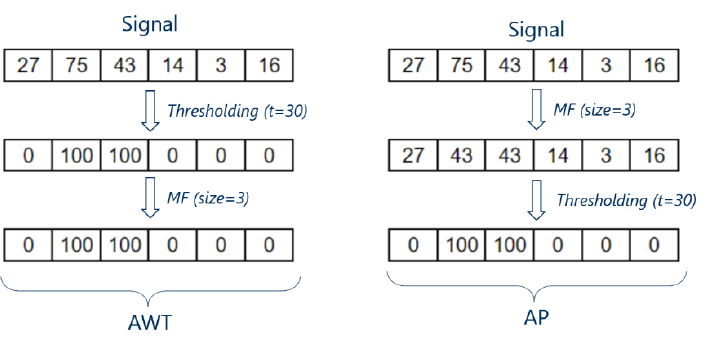
Figure A2. An example of the fact that MF and thresholding are commutative and therefore AWT and AP dives the same quantitative